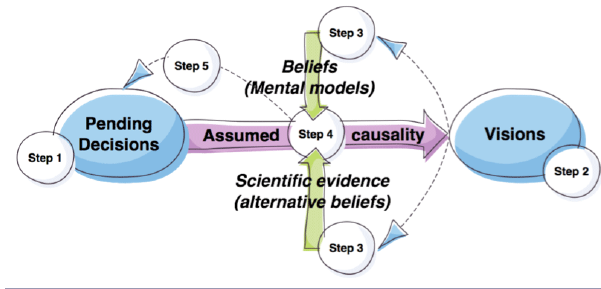
Fig. 2 . The ChaRL framework – Challenge and Reconstruct Learning (adapted from Smajgl and Ward 2013 a